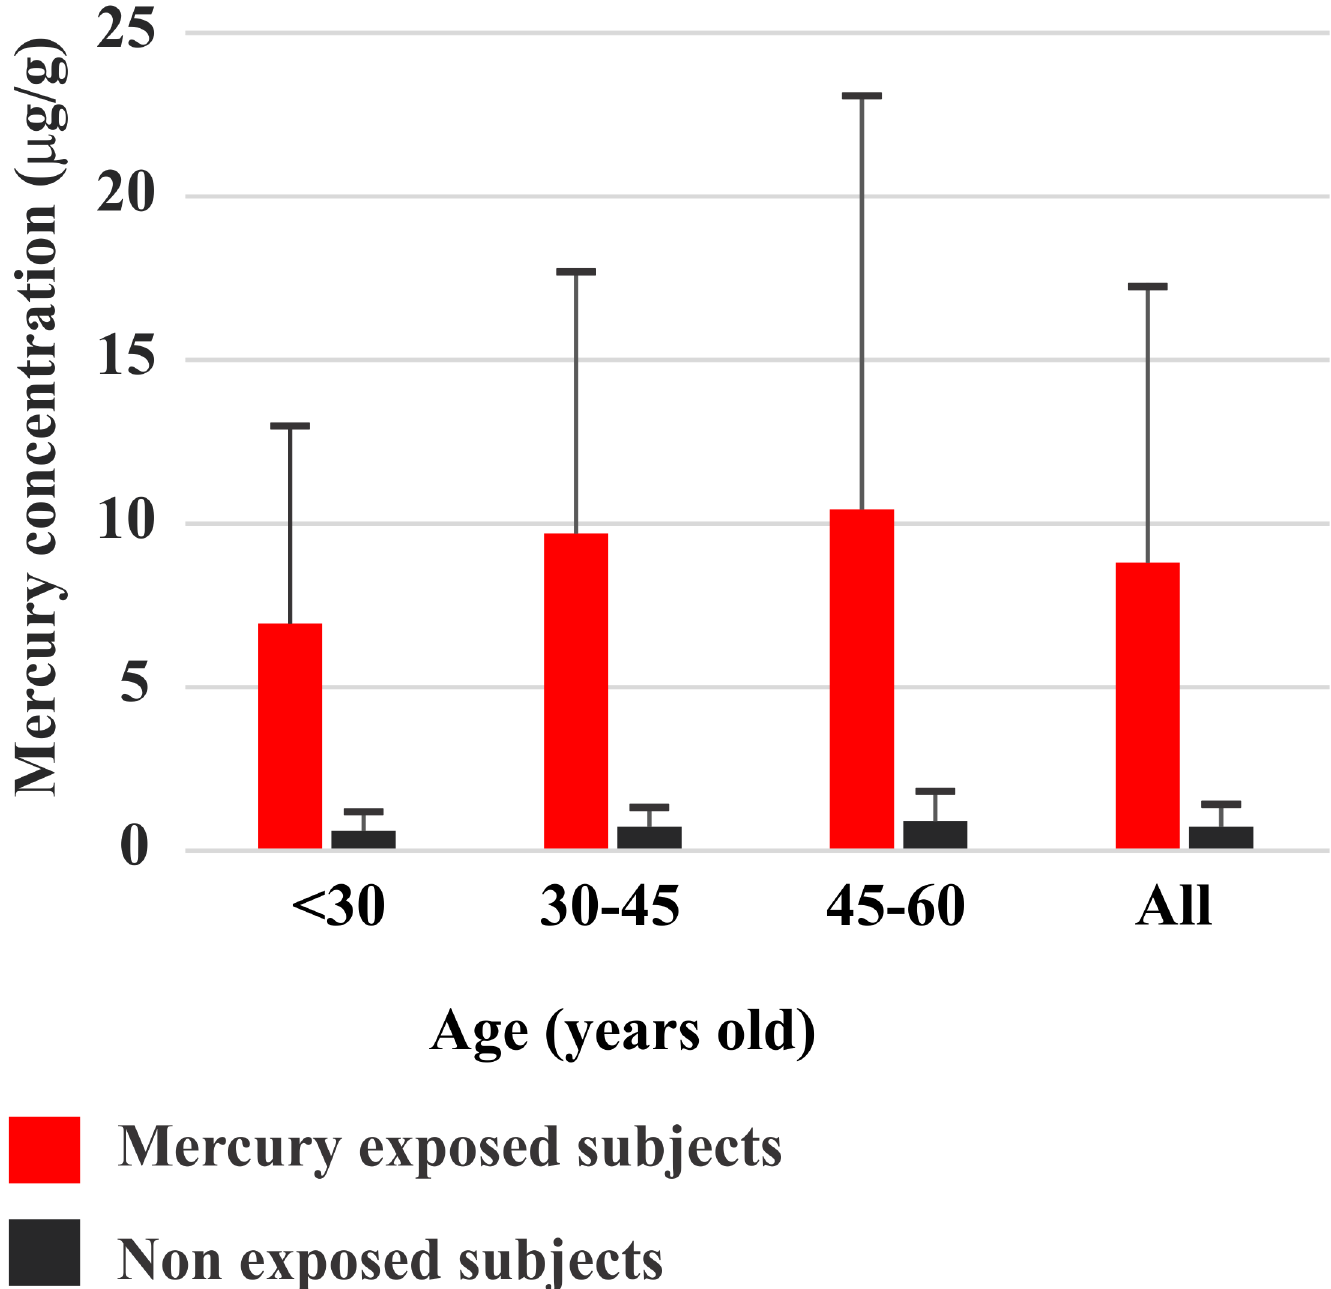
Fig 2. Mercury concentration in Amazon riverines. Comparison of the total Hg concentration found in two population of the Amazon: mercury-exposed inhabitants of the Tapajós river basin (red bars) and non-exposed inhabitants of the Tocantins river basin (black bars). Subjects were grouped by age. The rightmost bars grouped all subjects independently of age. Due to the influence of gold mining activity, inhabitants of the Tapajós have significant higher mercury levels than inhabitants from the Tocantins. In addition, mercury accumulates with age, reflecting the longer exposure to the metal.